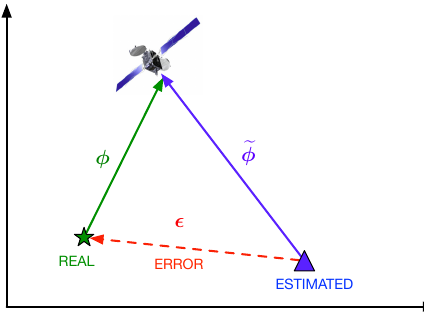
Figure 11. Illustration of the phase error computation based on the positioning